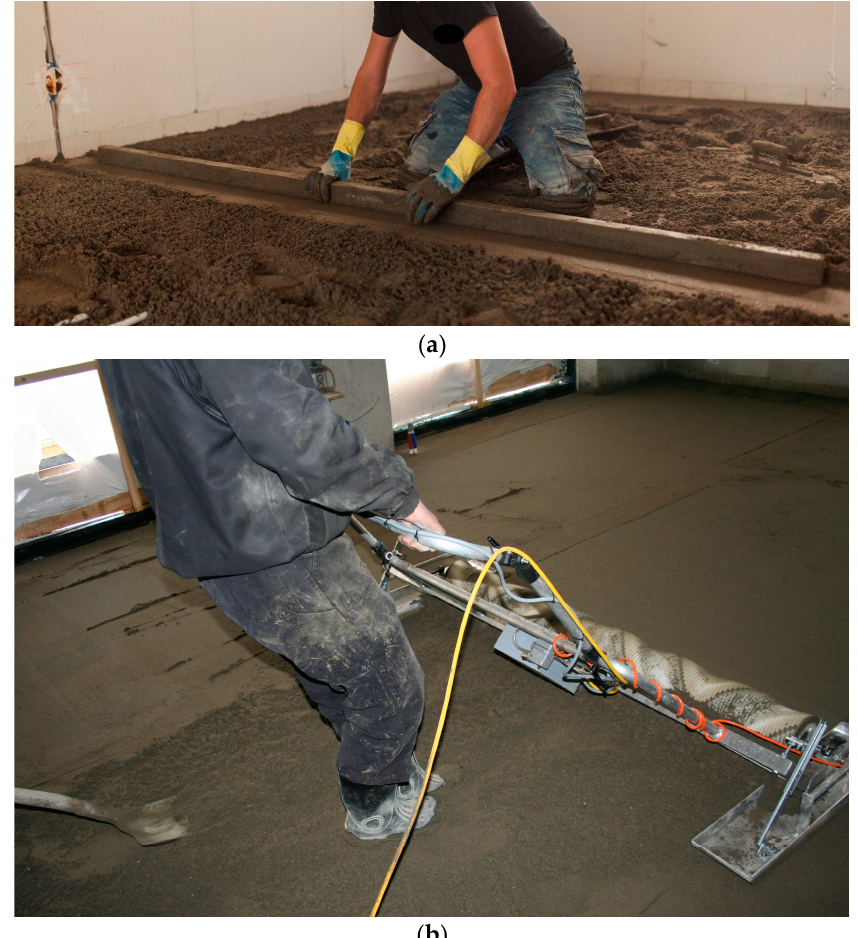
Figure 1. A sand–cement-bound screed floor layer working ( a ) using traditional working techniques and ( b ) using a manually movable screed-levelling machine.